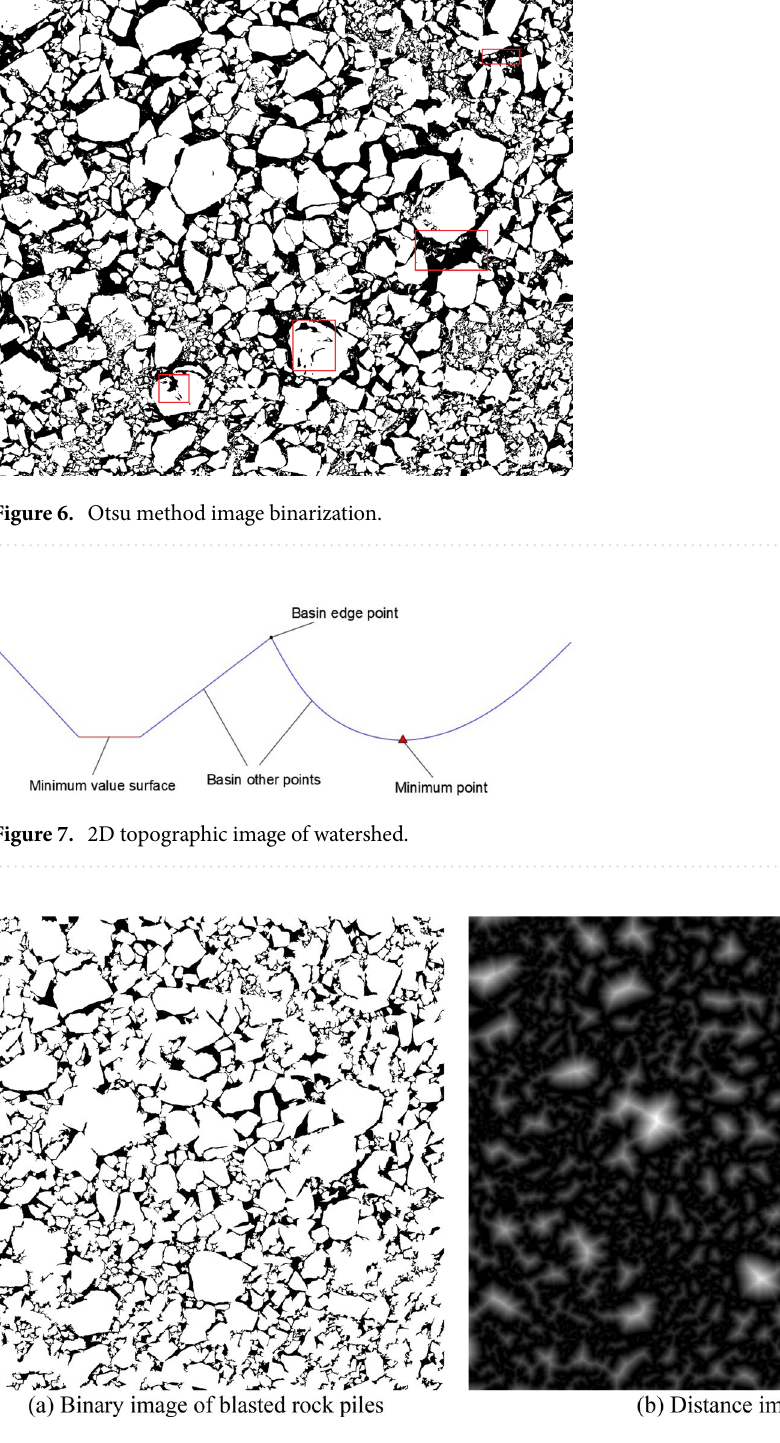
Figure 8. Distance